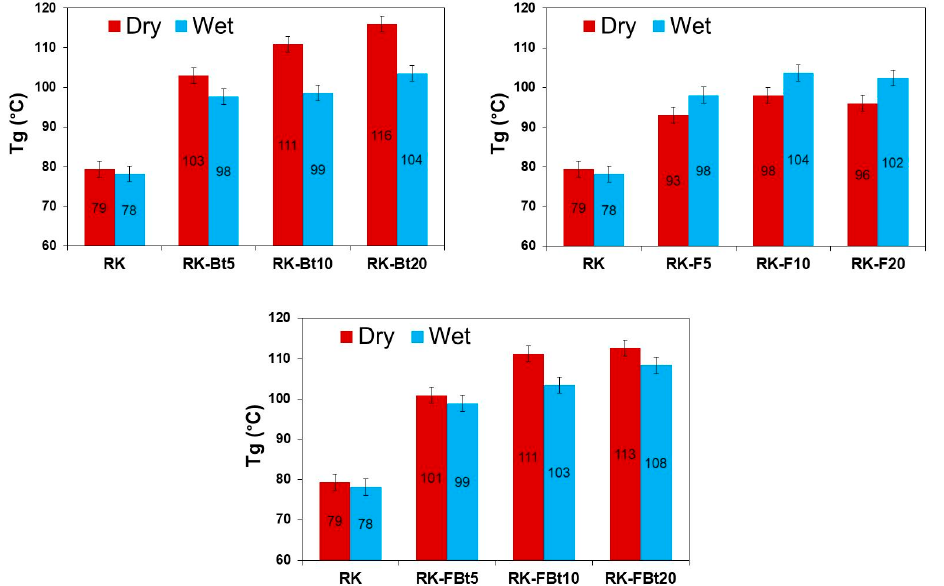
Figure 8. Glass transition temperature of all samples investigated, in wet and dry